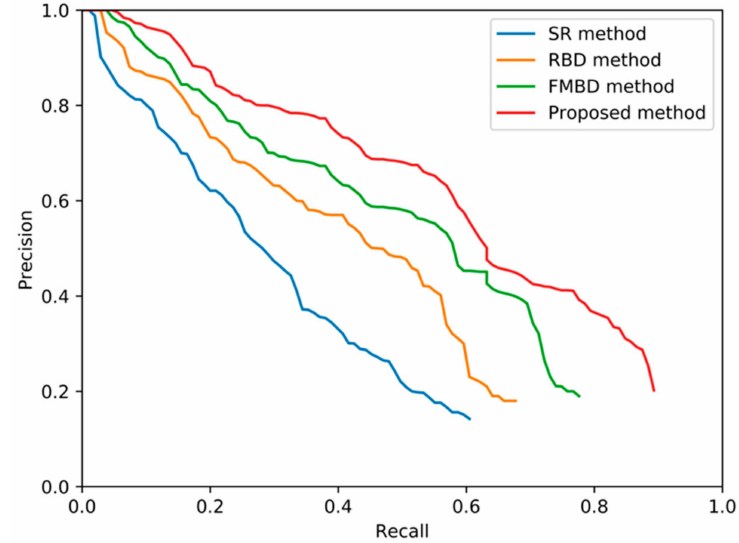
Figure 12. Precision-recall curves of the four object detection